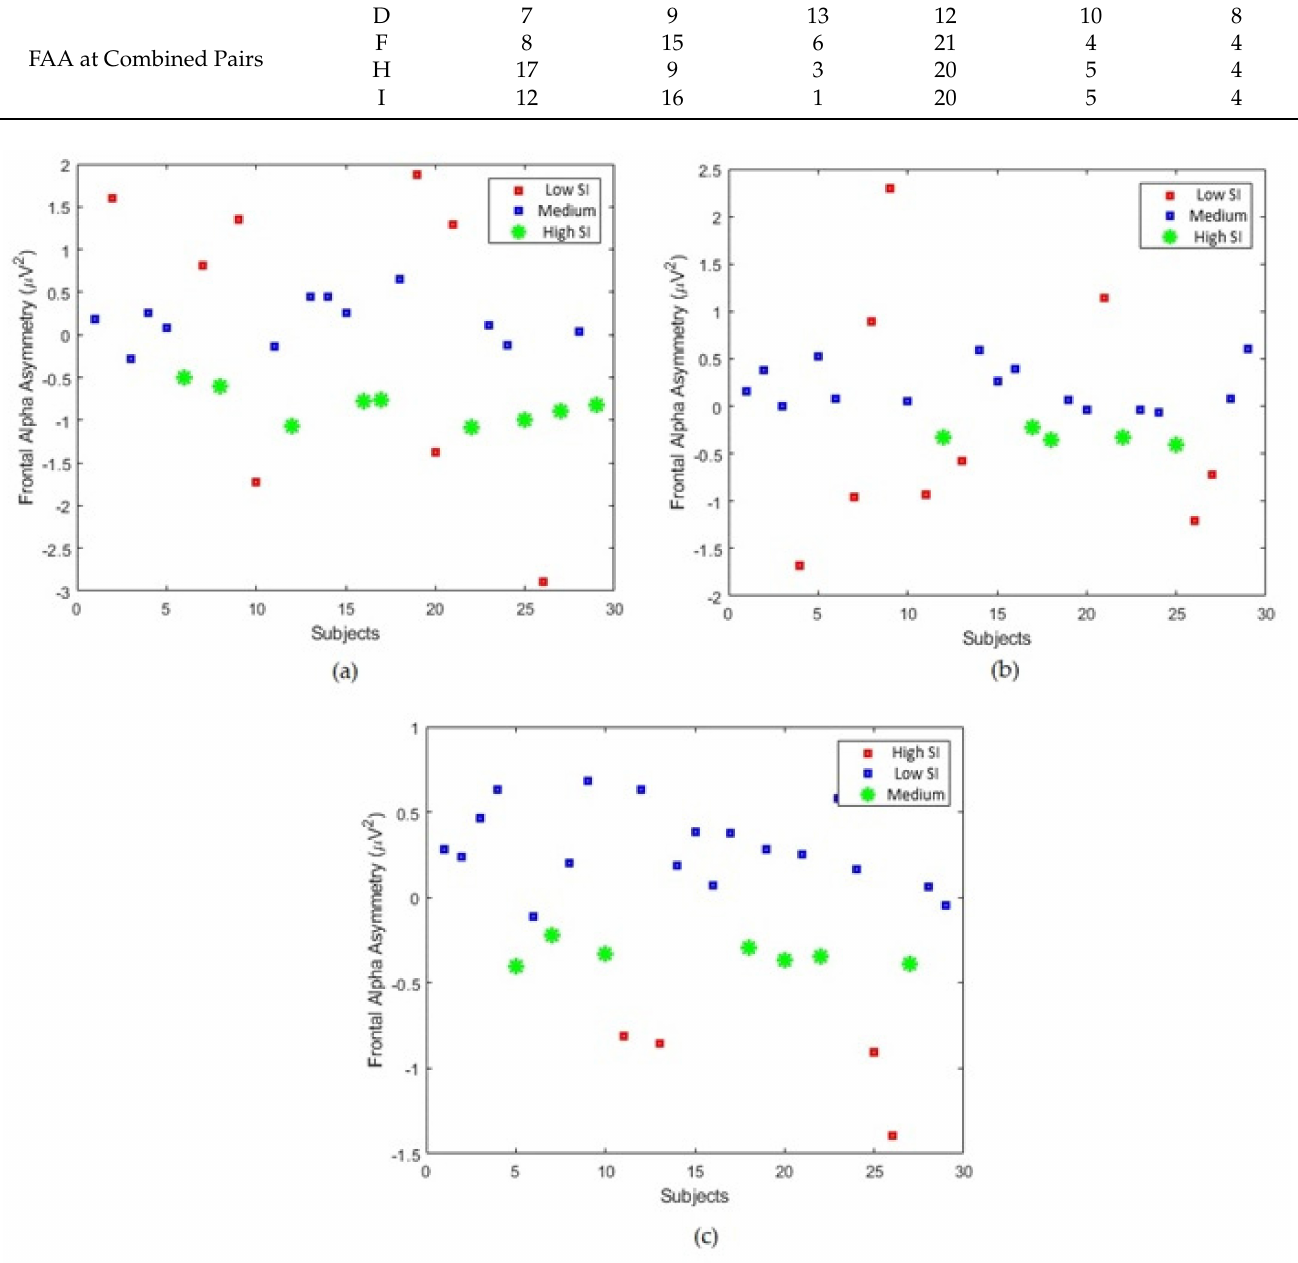
Figure 6. Example of DBSCAN clustering results for FAA metrics at the following electrode: ( a ) FP1- FP2, ( b ) F3-F4, and ( c ) combination of channel prefrontal and